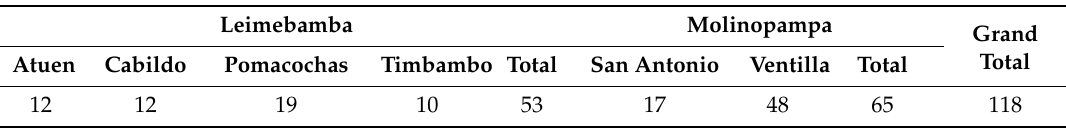
Table 14. Number of Functional Sectors (FS) of the four HAL-MWs in Leimebamba and two HAL-MWs in Molinopampa (Amazonas, Peru). Leimebamba Molinopampa Grand TotalAtuen Cabildo Pomacochas Timbambo Total San Antonio